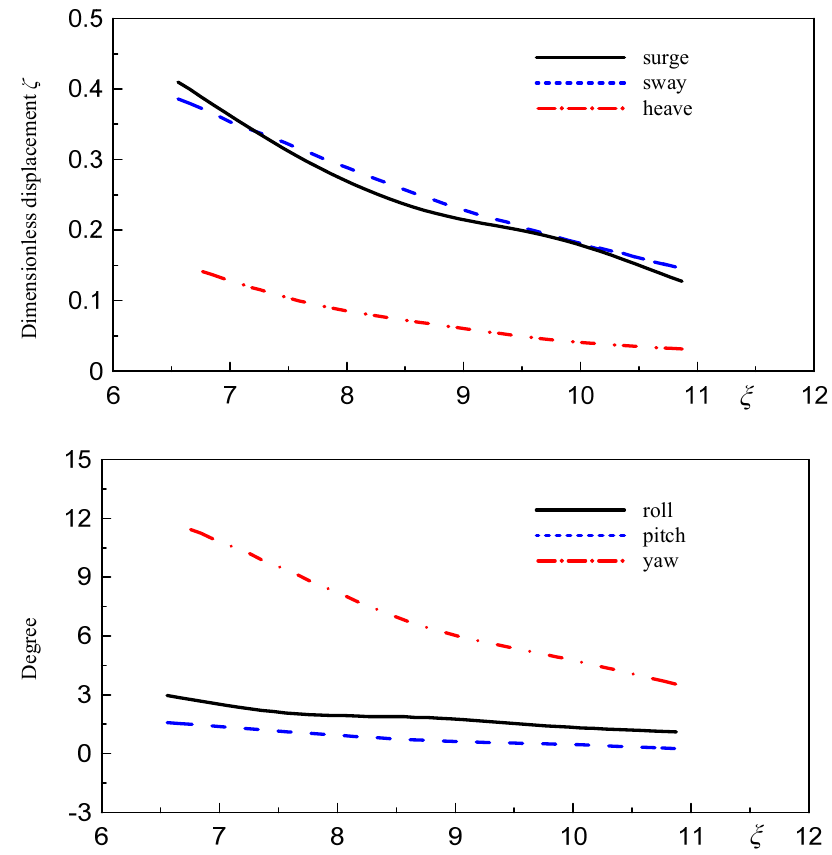
Figure 24. The responses of duct in different dimensionless submerged depths.